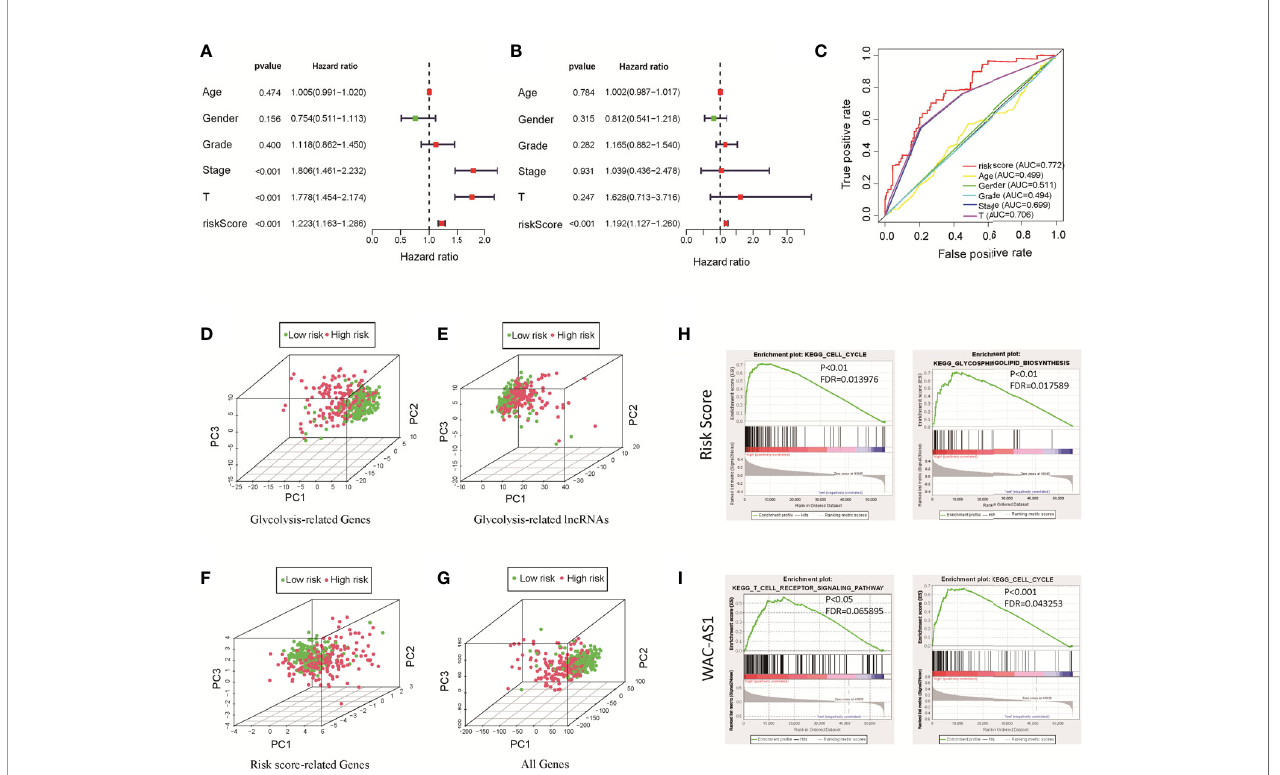
FIGURE 3 | Clinical relevance analysis, PCA and GSEA analysis results for the risk score and GR lncRNAs. (A) Univariate Cox regression analysis of clinical factors and the risk score; (B) multivariate Cox regression analysis of clinical factors and the risk score; (C) ROC curve; (D) PCA results for GR genes; (E) PCA results for GR lncRNAs; (F) PCA results for risk score-related lncRNAs; (G) PCA results for all genes; (H) GSEA results for the risk score; (I) GSEA results for